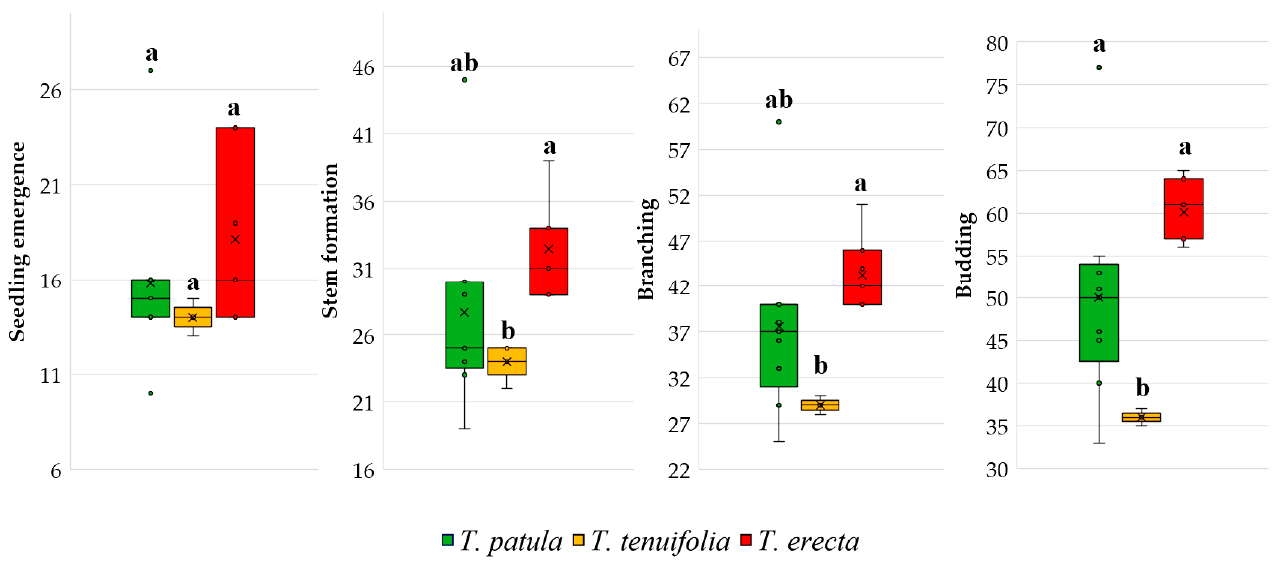
Figure 4. Main phenological stages based on the cultivars analysed in the three species of Tagetes . Each box plot represents minimum, lower quartile, median, upper quartile, and maximum values; in addition, the mean of the data is symbolised with a ‘ ✕ ’ into the boxplot. Different letters among boxplots indicate statistically significant differences for the respective trait, at a significance level of p < 0.05 (Duncan’s test).